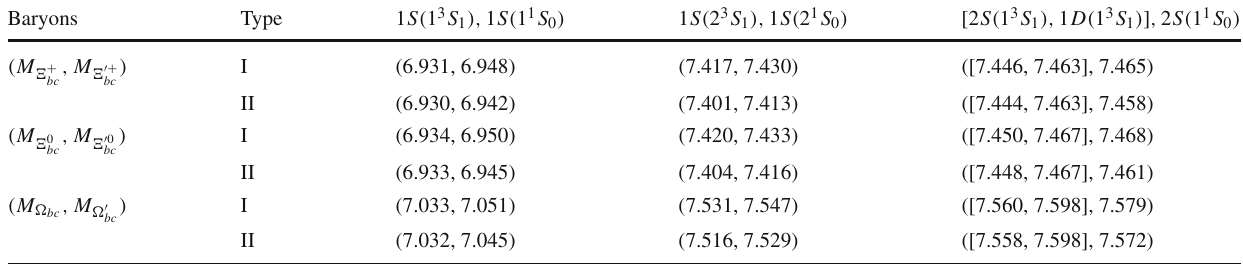
Table 1 Mass spectra(in GeV) of the low lying J P = 1 baryons. The baryon states are labeled by the notations NL ( n 2 S + 1 L J ) , where NL describe the radial and orbital quantum numbers between the ( bc ) -diquarks and the light quark, while ( n 2 S + 1 L